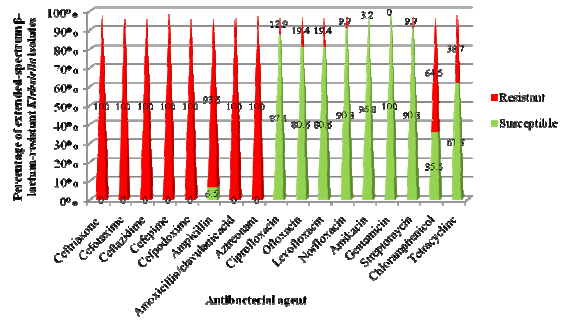
Fig. 3. Antibiogram of extended-spectrum ß